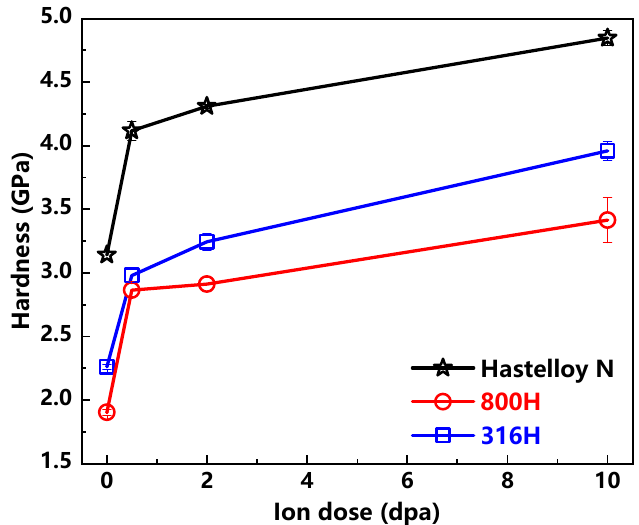
Figure 3. Experiment obtained H values versus ion dose of the Hastelloy N alloy, Alloy 800H and 316H stainless steel.